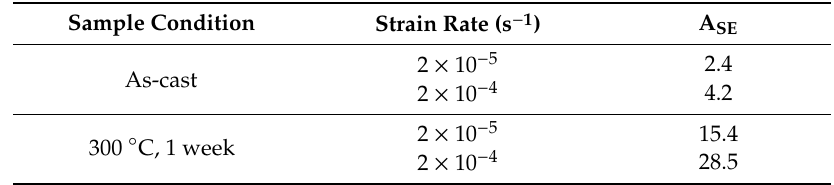
Table 1. Comparison of the A SE value for the as-cast and thermally annealed (300 °C, 1 week)